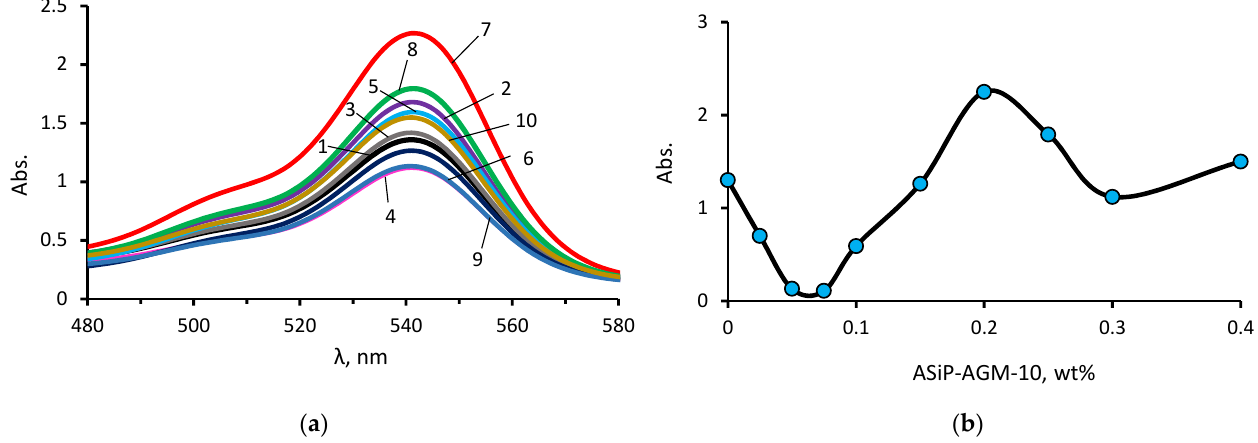
Figure 11. Spectra of Rhodamine 6G, sorbed on polymers obtained at [ASiP–AGM-10] = 0.0 (1), 0.025 (2), 0.05 (3), 0.075 (4), 0.10 (5), 0.15 (6), 0.20 (7), 0.25 (8), 0.30 (9) and 0.40 (10) wt.% ( a ); and the dependence of absorption coefficient (Abs, λ = 535 nm) on the content of the ASiP–AGM-10 ( b ).